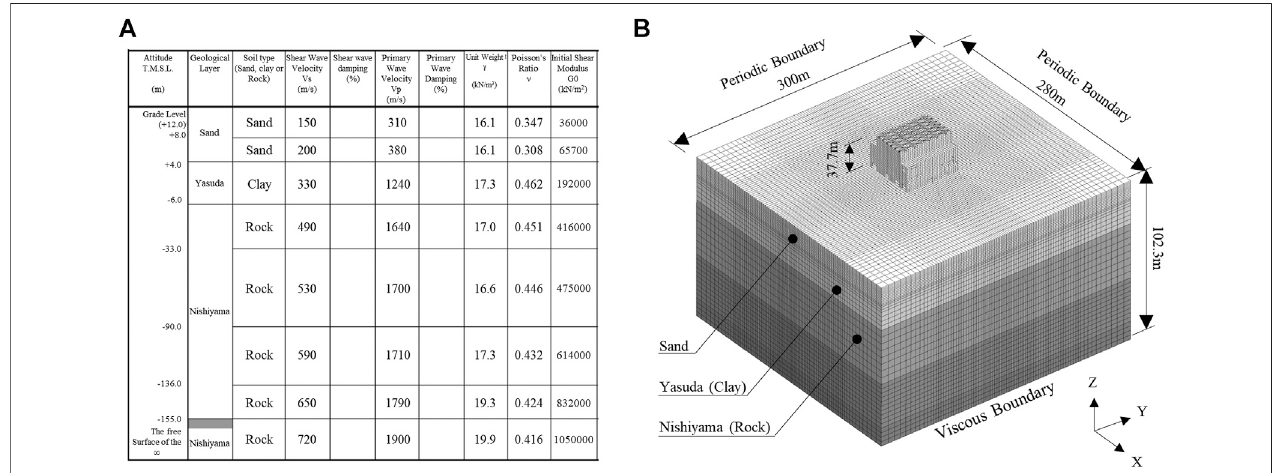
FIGURE 5 | Depiction of soil model. (A) Soil properties (IAEA, 2013). (B) Soil model considering SSI.